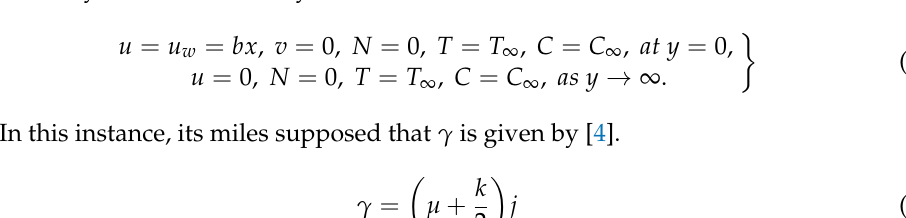
Figure 1. ( a ). Riga plate geometry. ( b ). Graphic description of the system. Laterally with the boundary